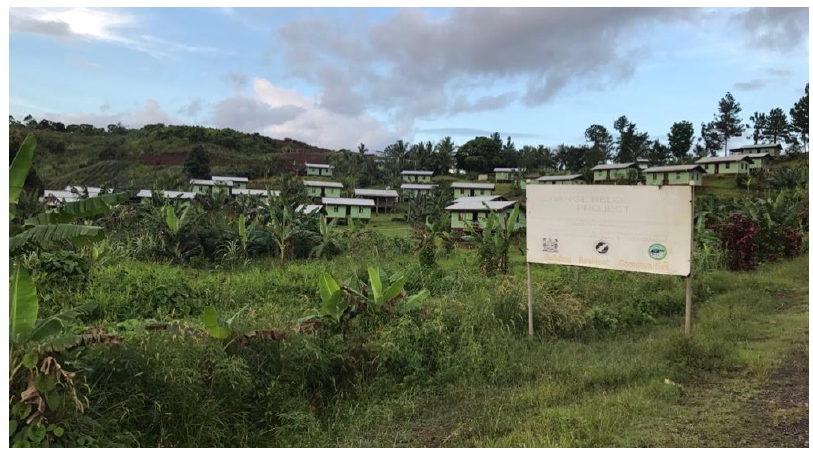
Figure 2. The new village relocation site of Vunidogoloa.